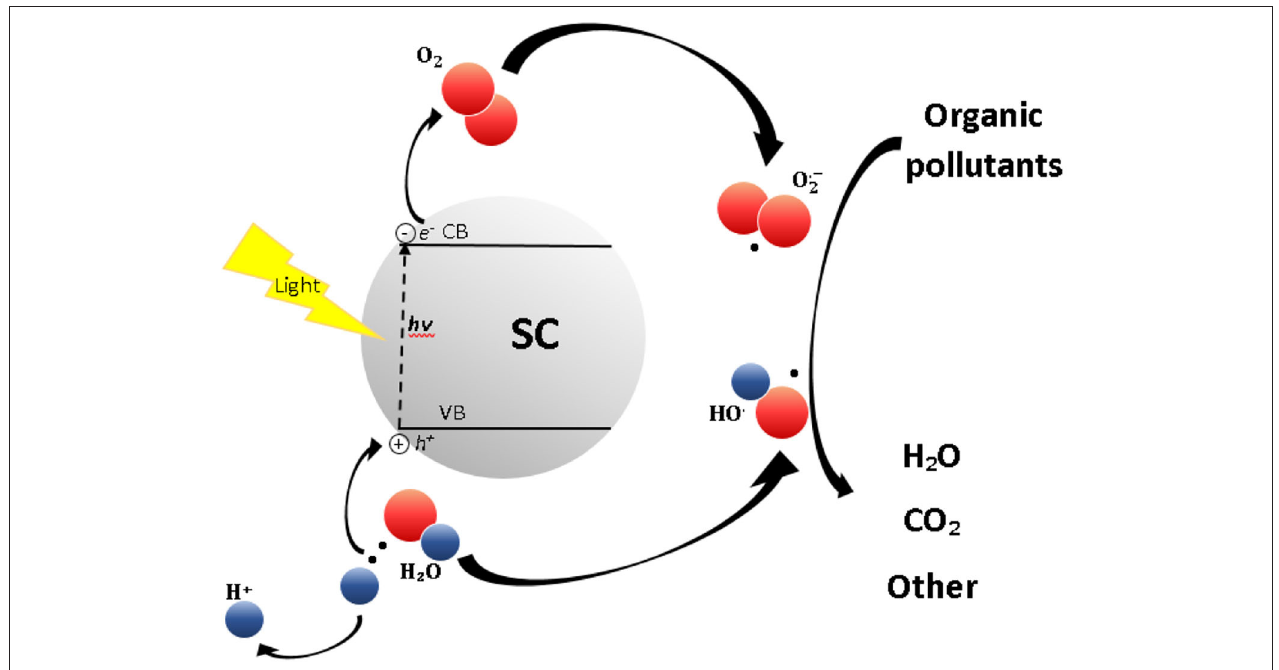
FIGURE 3 | Schematization of a photoexcitation